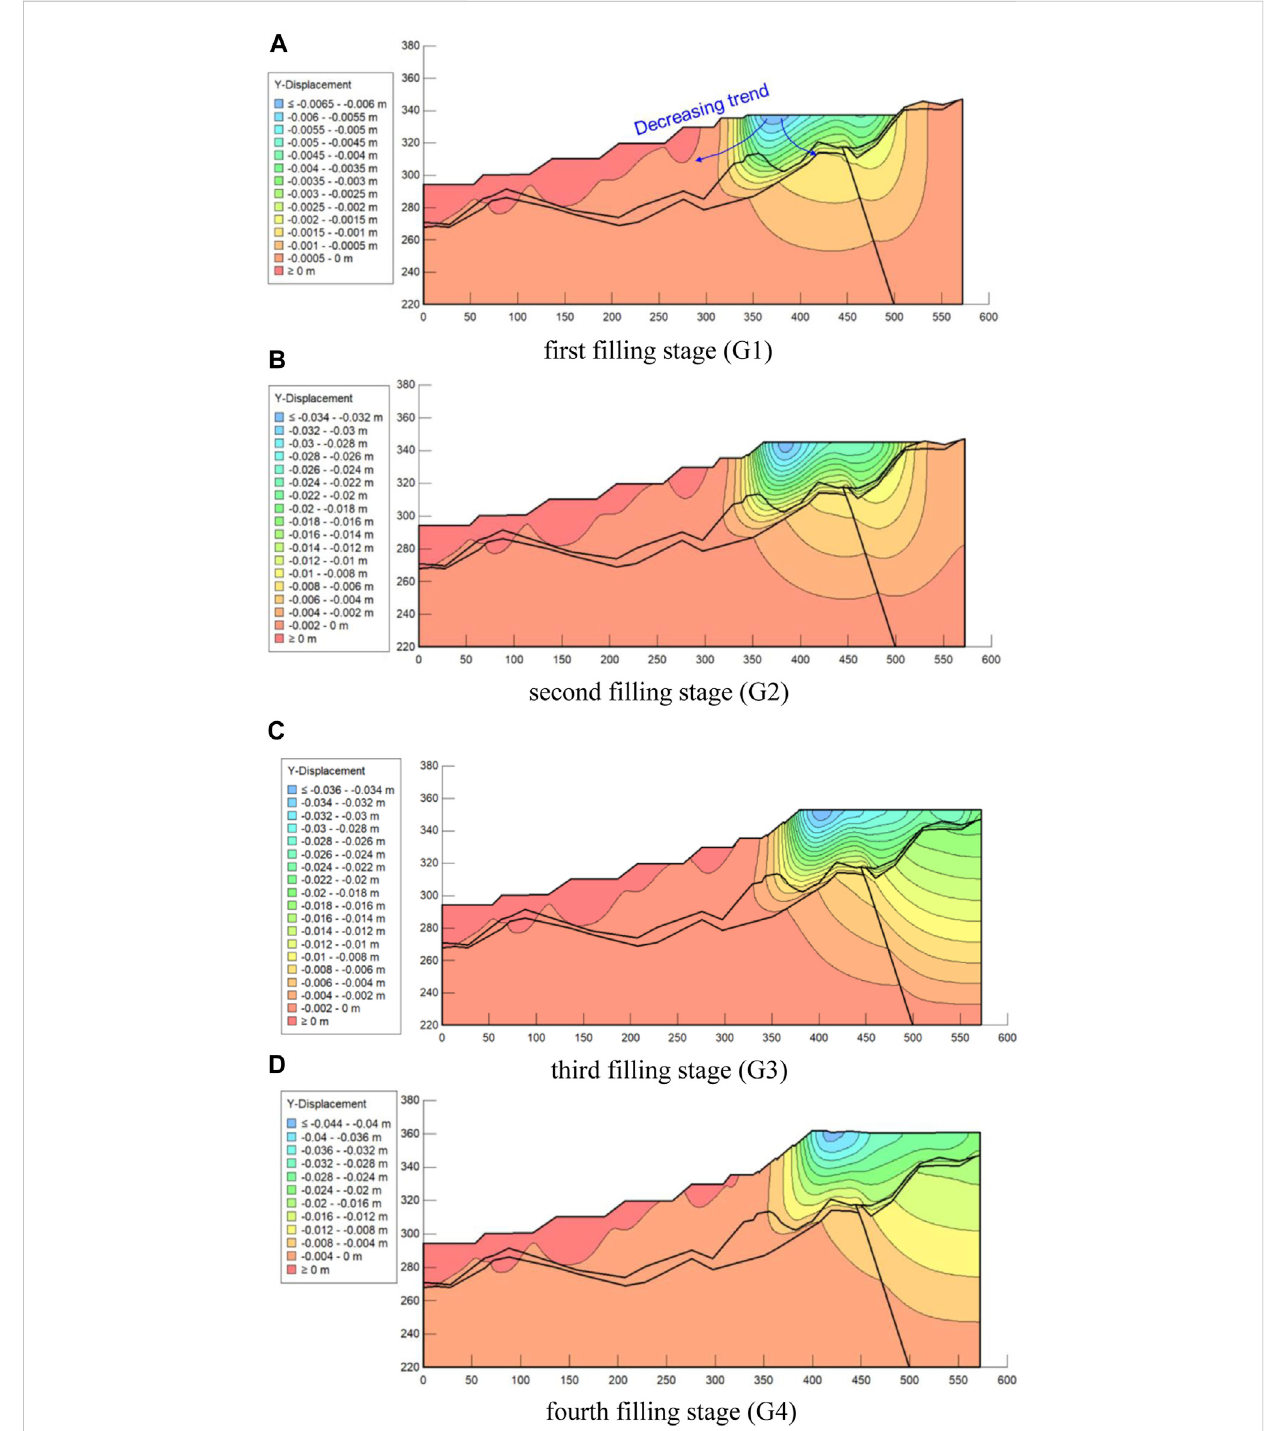
FIGURE 10 Incrementaldisplacementdistributioncontourofthehigh- fi lleddepositslopeinthey-directionduringtheGarea fi llingprocess: (A) fi rst fi llingstage (G1); (B) second fi lling stage (G2); (C) third fi lling stage (G3); (D) fourth fi lling stage